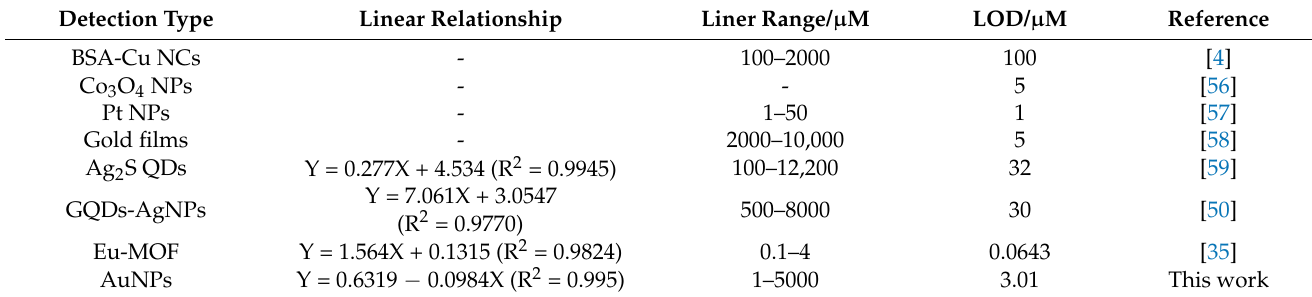
Table 2. Comparison of this work with other methods for glucose detection.